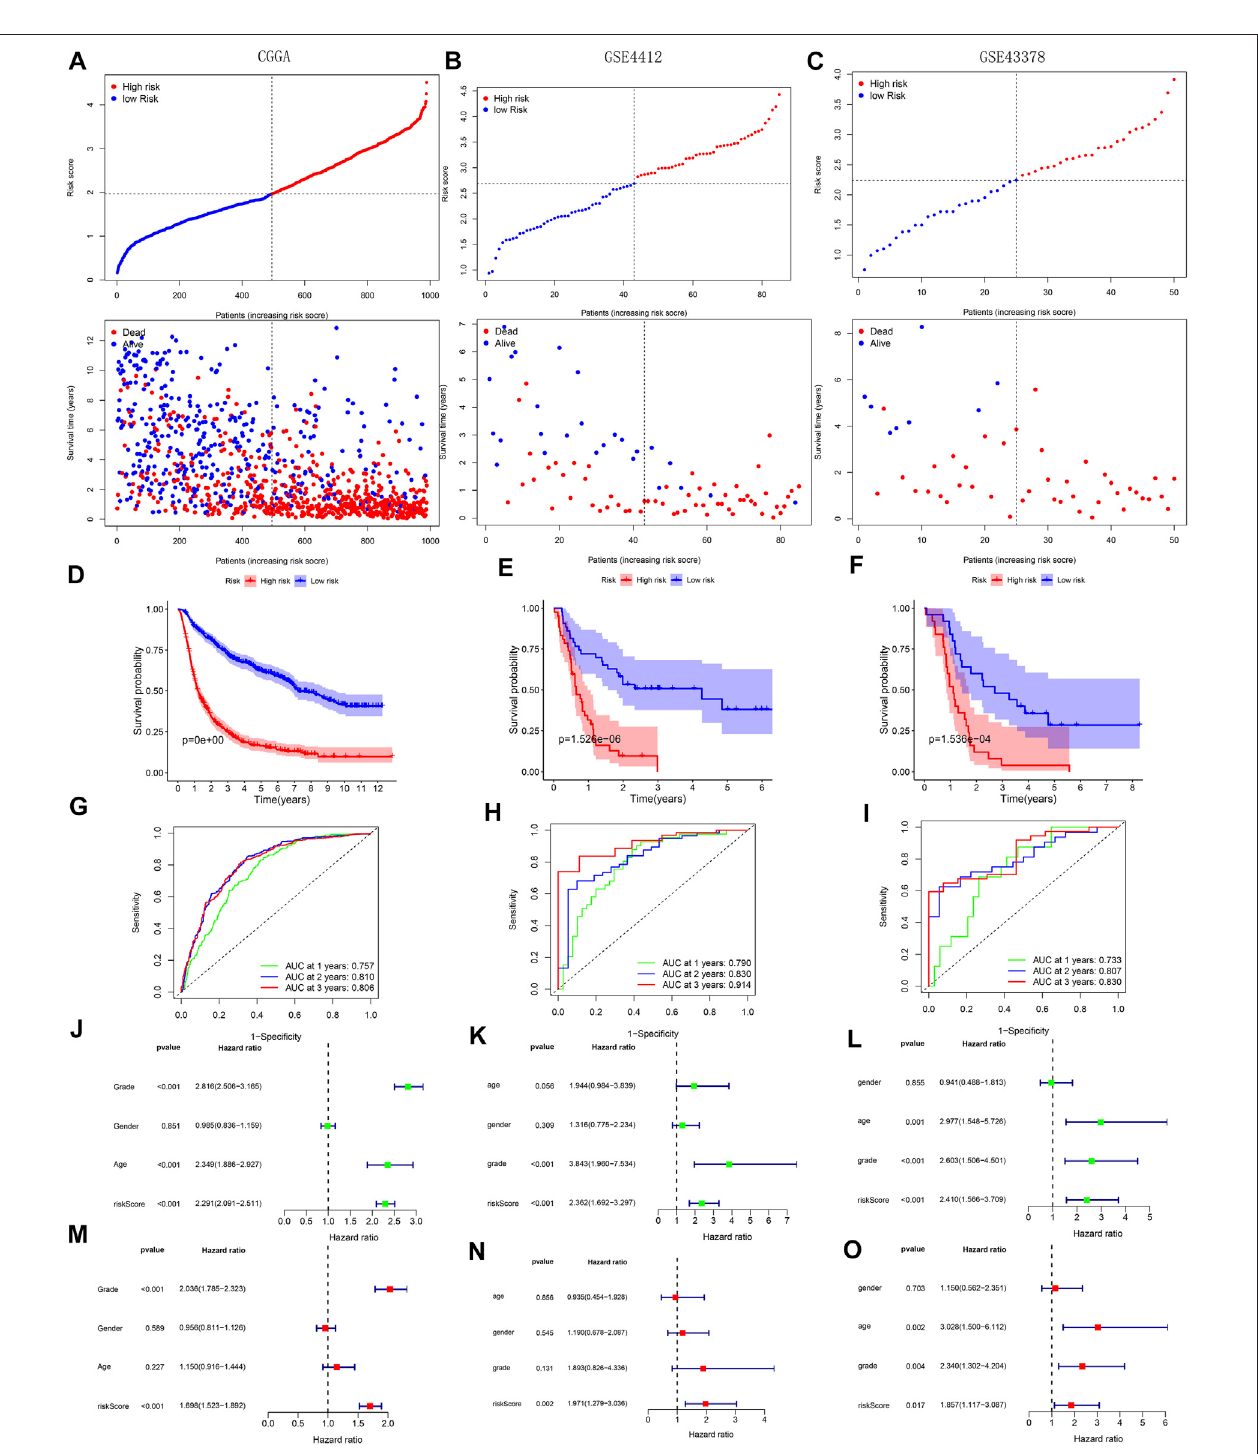
FIGURE 6 | Validation of model ’ s predictive performance using the data of the CGGA, GSE4412, and GSE43378 cohorts. (A – C) Risk curves and survival point plots with increasing risk score. (D – F) Survival curves. (G – I) ROC curves of OS at 1-, 2-, 3-years. AUC > 0.5 is considered to have a predictive value. (J – O) Forest plots re fl ecting the results of univariate and multivariate cox regression analyses.